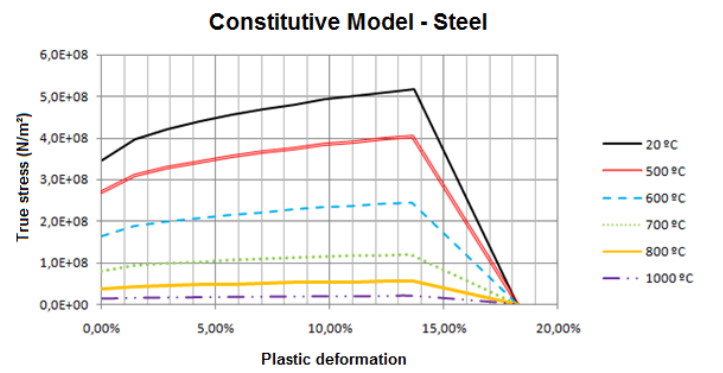
Figure 5. Steel mechanical properties.